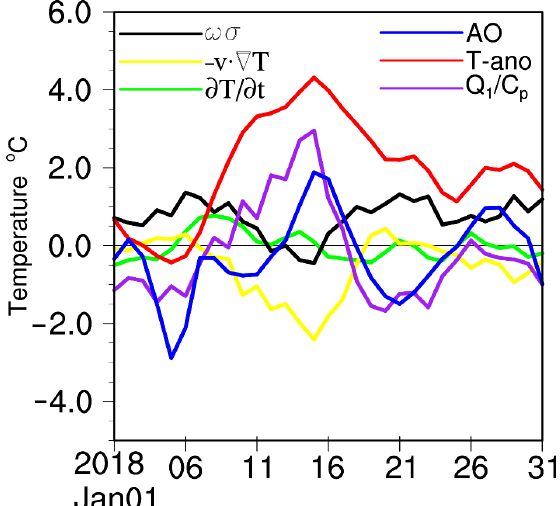
Figure 8. Different items of the temperature diagnostic equation, AO index and mean temperature anomaly between 1000 and 300hPa averaged over the Arctic (67°–90° N). The blue curve shows the AO index, red is the Arctic temperature anomaly, purple is the diabatic heating ( Q 1 convection item ( ωσ ), yellow is the advection term ( − v × ∇ T ), and green is the local variation of temperature ( ∂ T ).